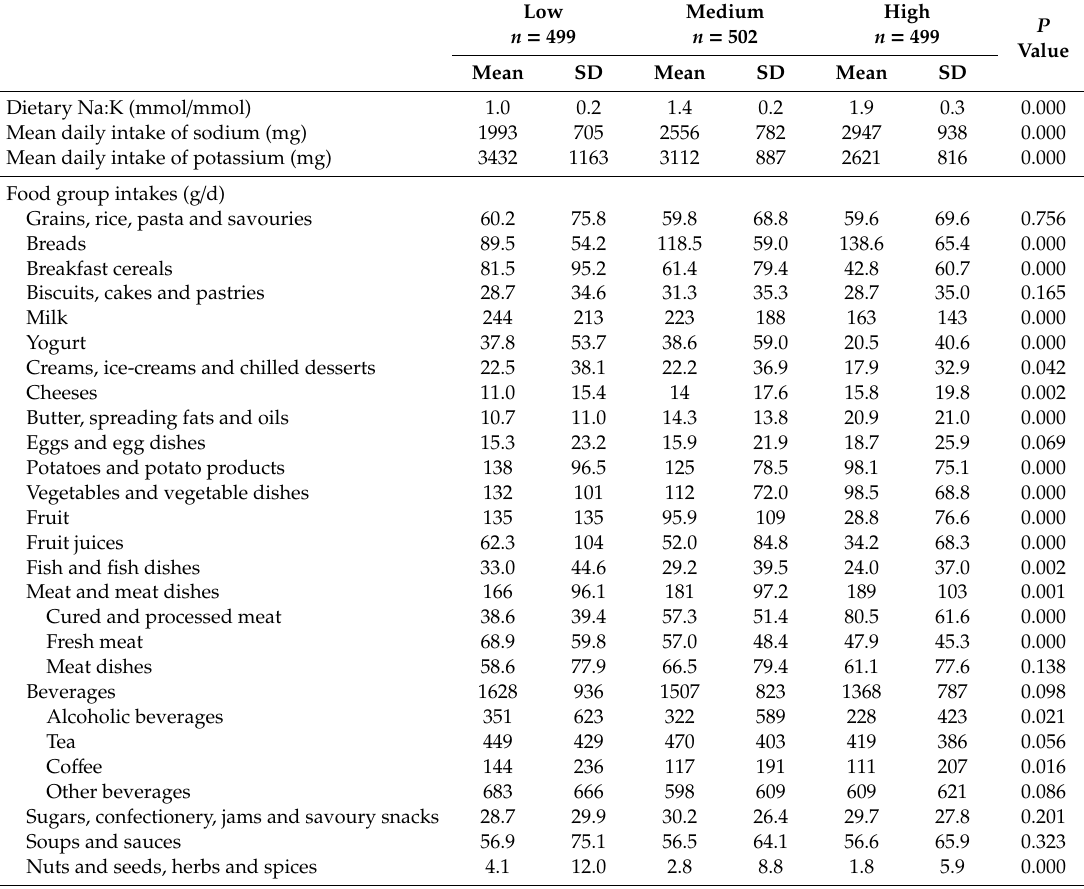
Table 3. Dietary intake of sodium, potassium, dietary molar Na:K and food group intakes in Irish adults ( n = 1500) by tertile of dietary molar Na:K (stratified by age group and gender).